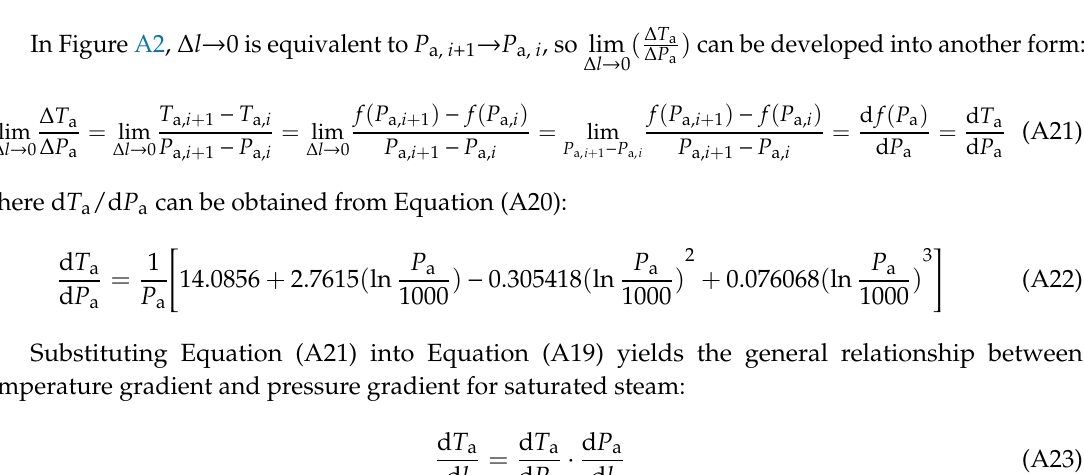
Figure A2. Comparison of empirical correlation with steam-table data.